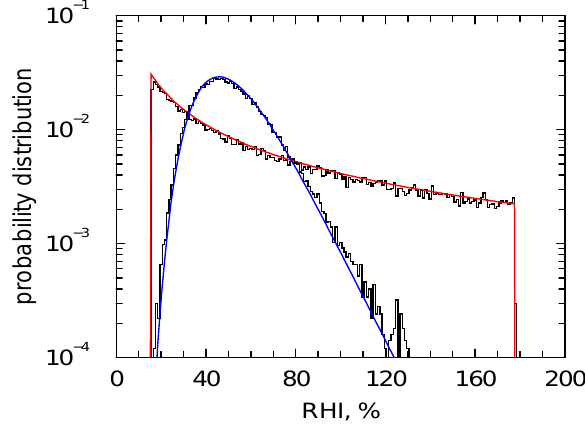
Fig. 1. Probability distributions of RHI obtained with a uniform distribution of T in the interval 215–235 K (red curve) and a nor- mal distribution with T o = 225 K and σ = 2 . 5 K (blue curve). The stair steps depict the corresponding discrete distributions obtained with random samples of T , using 50,000 individual random num- bers binned into 1% intervals.